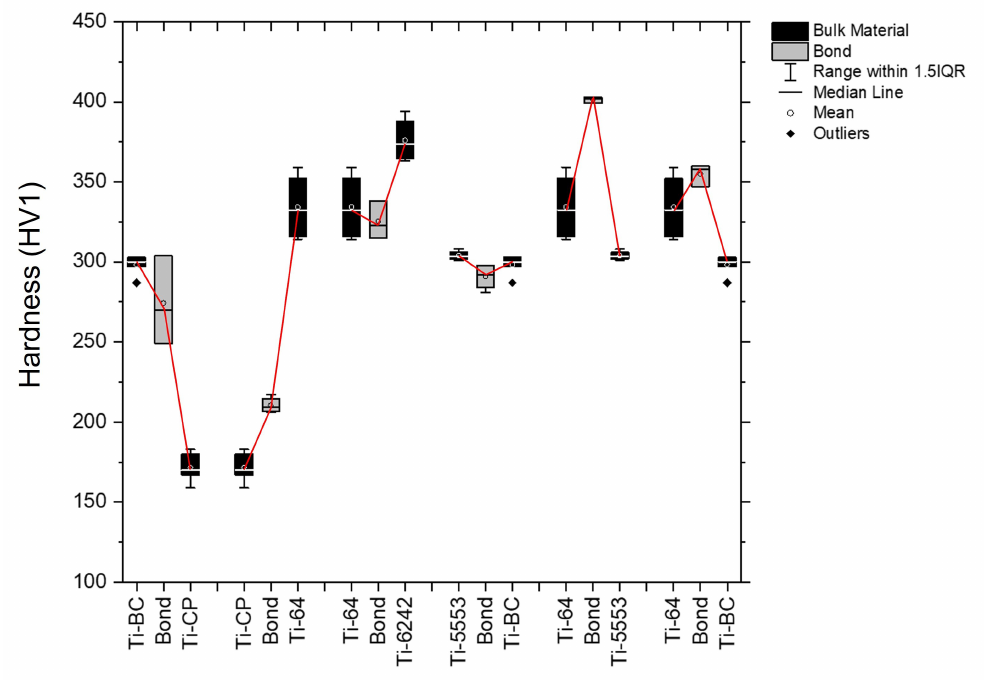
Figure 2. Bulk and bond Vickers hardness for alloy pairs where the Vickers hardness indentation load was 1 Kg